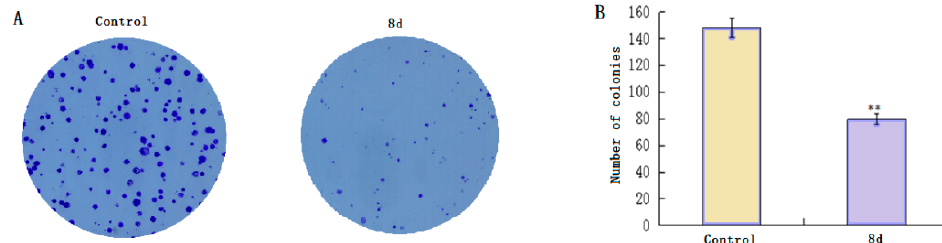
Figure 4. Compound 8d inhibited cell colony formation. ( A ) Representative images of HepG2 cells colonies after treatment with 8d (7 µ M). The plates were stained with Coomassie Blue. ( B ) Data are presented as the mean ± SD of three experiments. ** p < 0.01.